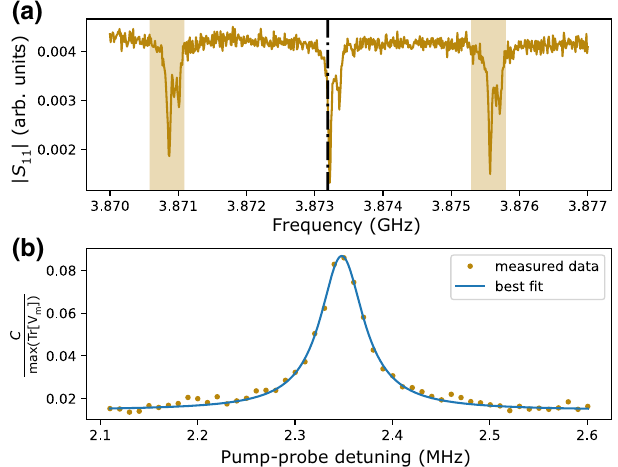
FIG. 8. Gain estimation. Top: frequency sweep depicting the three SAW modes of interest. A pump is positioned at the ver- tical black dashed line, while noise is measured at frequencies symmetric around the pump, as indicated by the shaded region. Bottom: the correlation quantity C is plotted as a function of pump-probe detuning. A fit to C is made to extract the gain of our amplification chain, assuming an effective phonon temperature of 30 mK. From the fit we obtain G ≈ 80 dB. The fit also provides | (cid:8) | ≈ 6 kHz. For comparison, C is scaled by the maximum trace max ( Tr[ ˜ V ] ) measured across all frequencies.